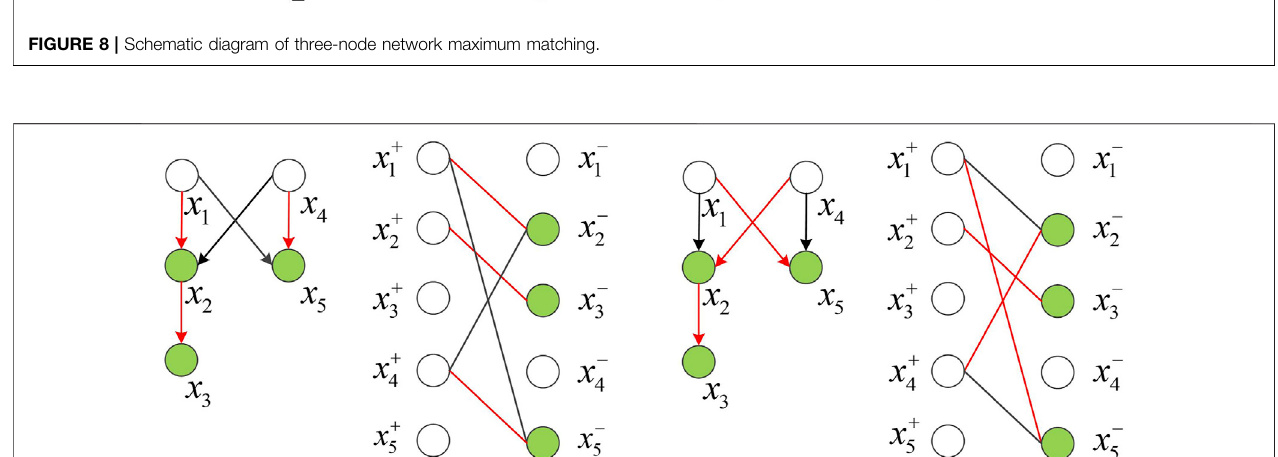
Frontiers in Mechanical Engineering |